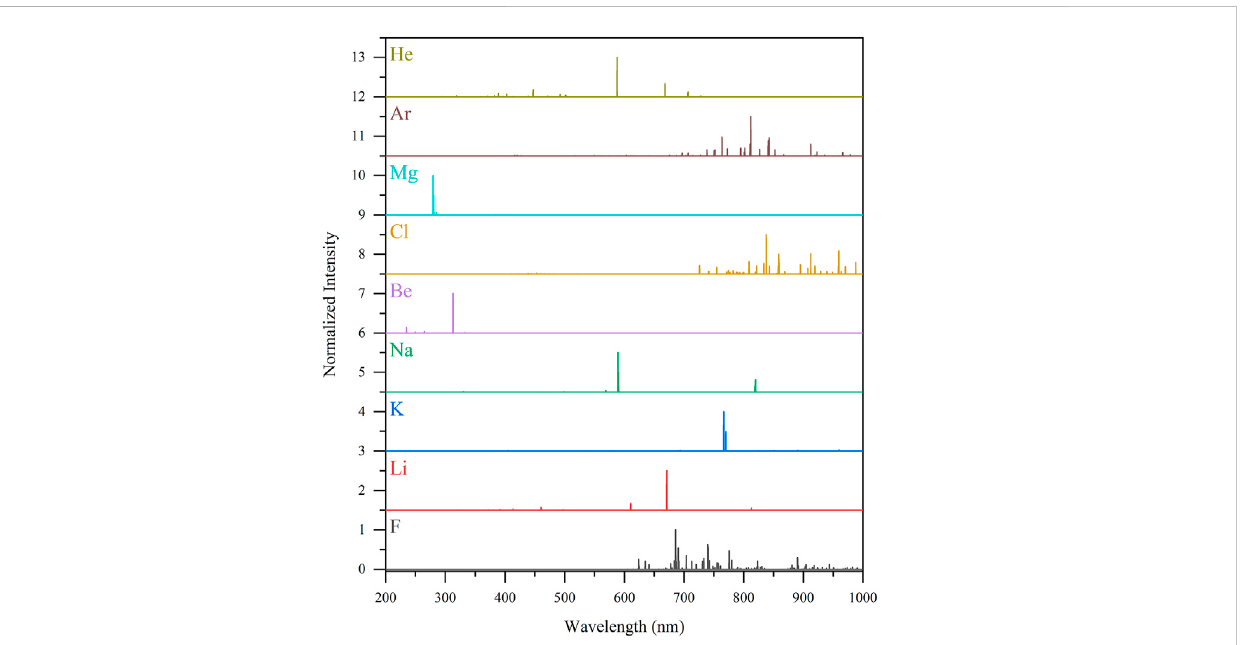
FIGURE 3 Fluoride-andchloride-saltspecies ’ andcarriergascandidates ’ LIBSemission pro fi lescomparedataplasmatemperatureof1 eVandelectronnumberof 10 17 cm − 3 . The spectral intensities have been normalized (0 – 1) to their maximum intensity for comparison